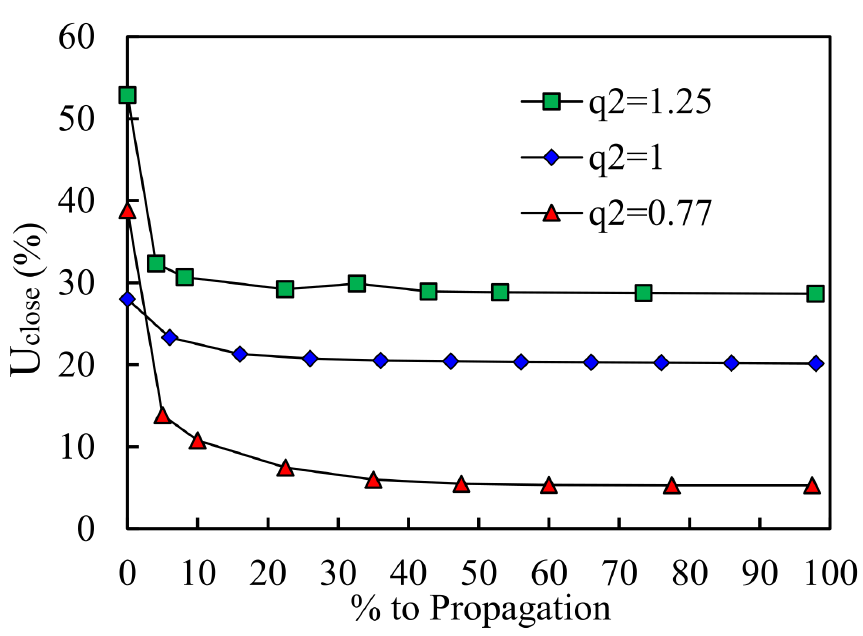
Figure 11. Crack closure level for distinct values of q 2 . Results are presented in terms of the percentage of load cycles completed to the load cycles needed to propagation to occur.